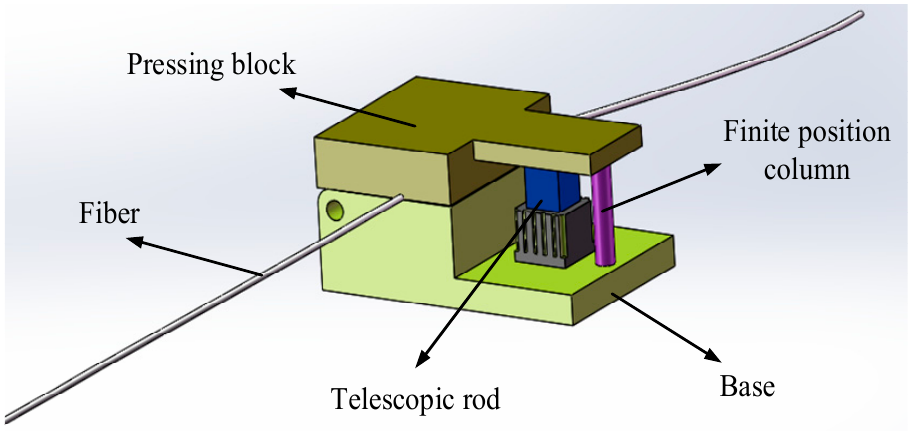
Figure 2. Schematic diagram of the mechanical Q-switched device.